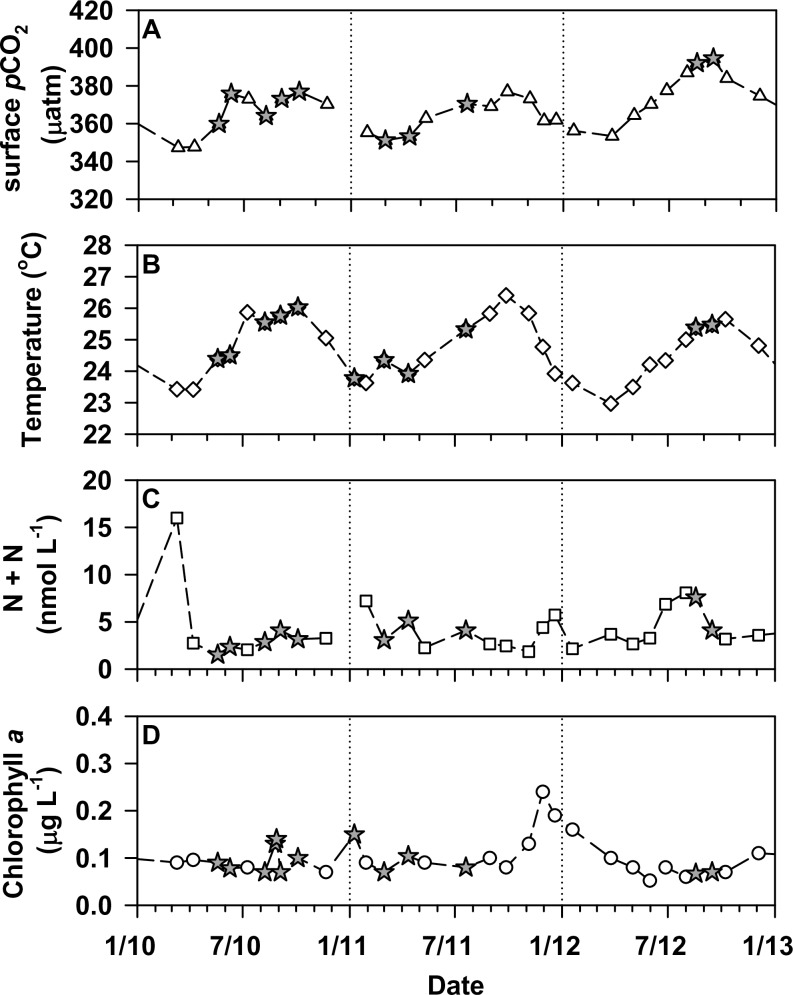
Initial experimental conditions.Mixed layer seawater pCO2 measured during the period of this study (2010–2012) at Station ALOHA (panel A; triangles). Also shown are temperature at Station ALOHA (panel B; diamonds), concentrations of nitrate + nitrite (N+N; panel C; squares) and chlorophyll a (panel D; circles) in near-surface waters (5 m). Grey stars are used to indicate those cruises when bubbling experiments were conducted.